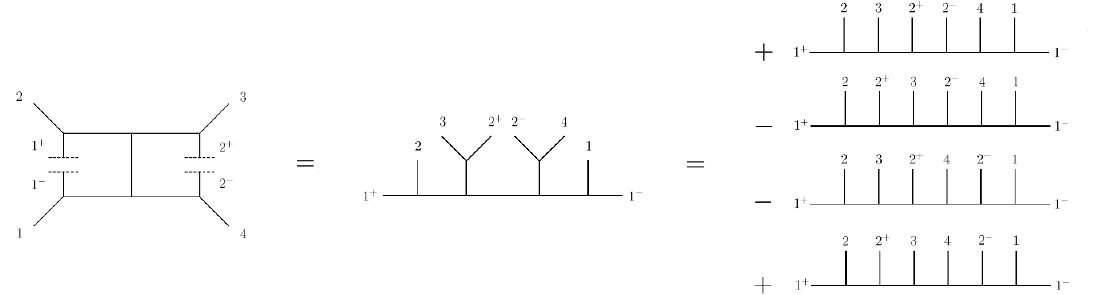
Figure 17 . Tree-level-like diagram contributing to a planar double-box. Jacobi relations are used twice to derive the kinematic numerator from the numerators of (half-ladder) master diagrams of the type in (cid:12)gure 10.